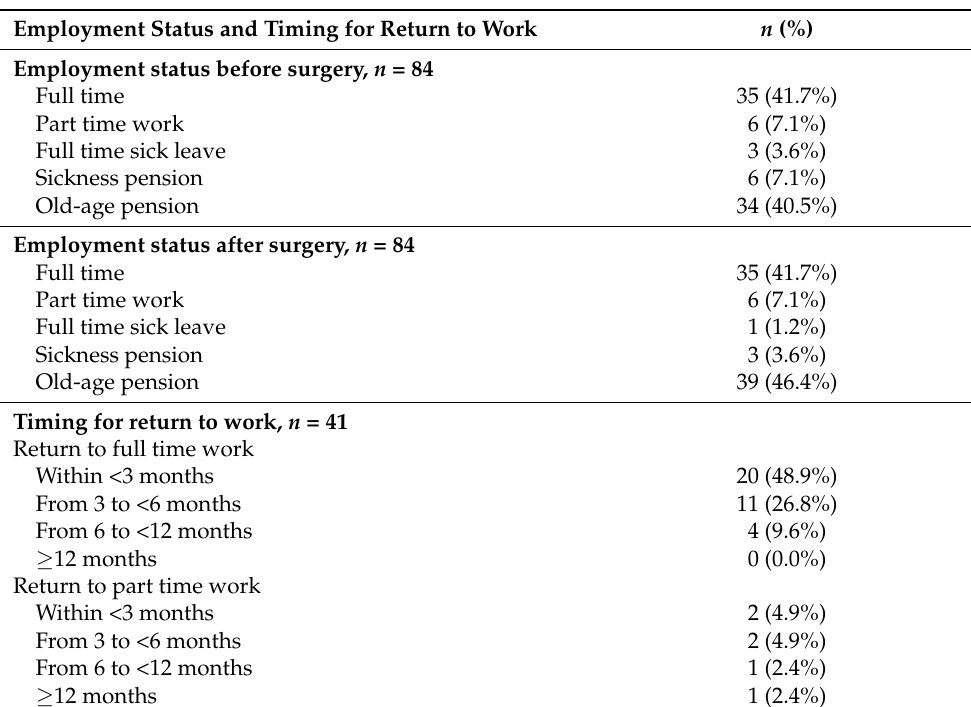
Table 4. Employment status and return to